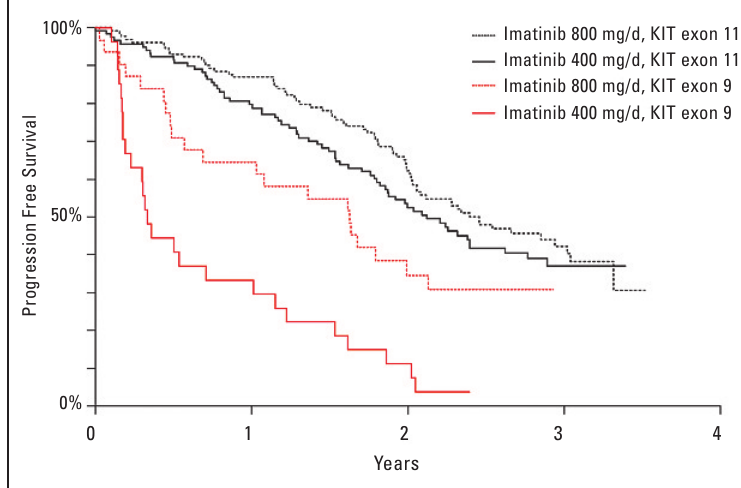
Impact of the randomly allocated initial dose of imatinib on time to progression in patients harbouring tumour with KIT exon 9 or 11 [data from 94].